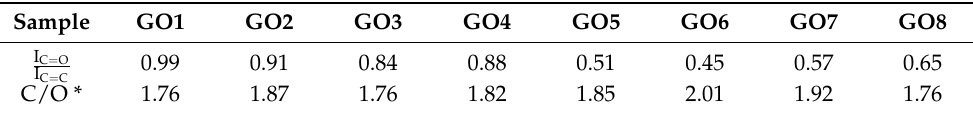
Table 2. I C = O ratio calculated for obtained graphene oxides and C/O ratio in the obtained graphene I C = C oxides determined based EDS